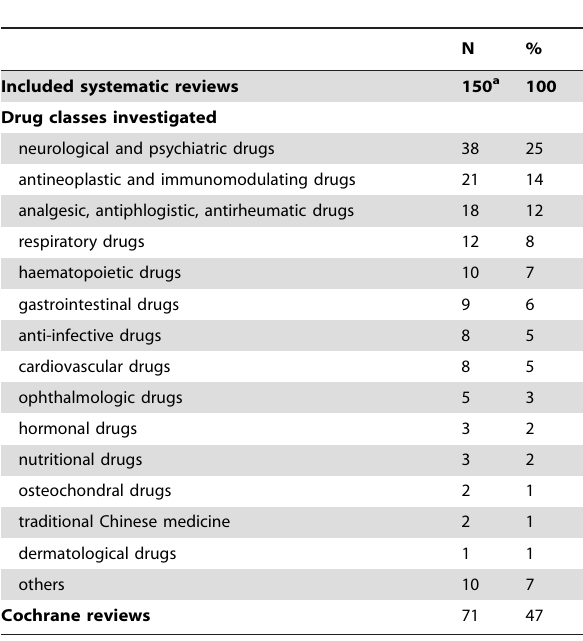
Table 1. General characteristics of included systematic reviews.